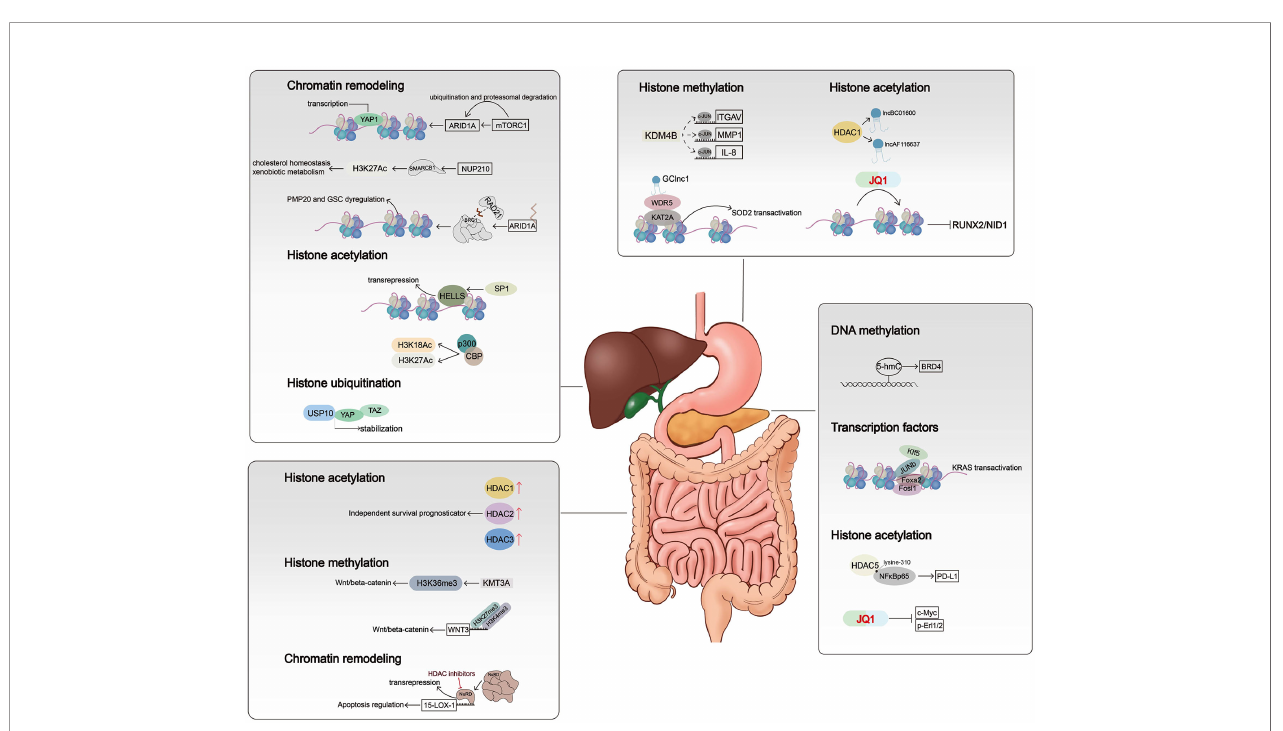
FIGURE 2 | Mechanisms of chromatin alterations regulating digestive system tumors. Histone modi fi cations, chromatin remodelers, and DNA methylation affect critical signal pathways not only by altering gene expression levels but also by regulating chromatin accessibility.